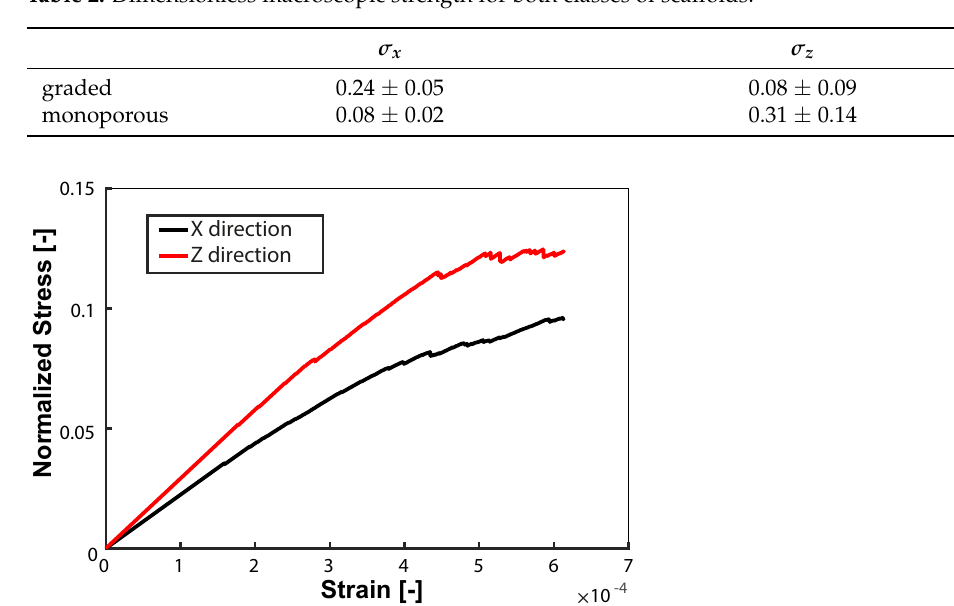
Figure 2. 3D representation of the macroscopic stiffness of the scaffolds: ( a ) cubic symmetry scaffolds, ( b ) low porosity scaffolds and ( c ) scaffolds exhibiting detaching of fibers. Table 2. Dimensionless macroscopic strength for both classes of scaffolds.